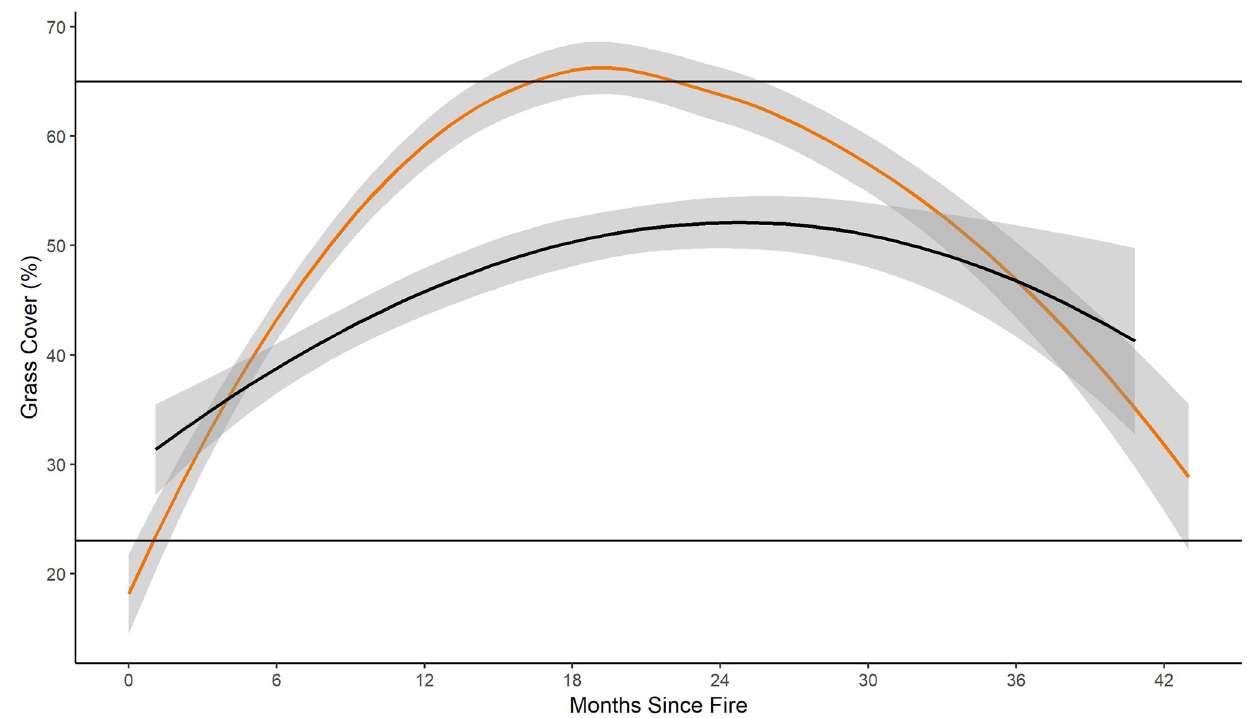
Fig 2. Percent grass cover. Percent grass cover for fire-only (orange) and pyric herbivory (black) treatments at all sites from 2014 to 2016. Shaded area indicates 95% confidence interval. Horizontal lines represent the minimum (~23%) and maximum (~65%) grass cover reported used for nesting by Tympanuchus spp. � Regression lines and confidence intervals generated using “loess” locally-weighted smoothing function.